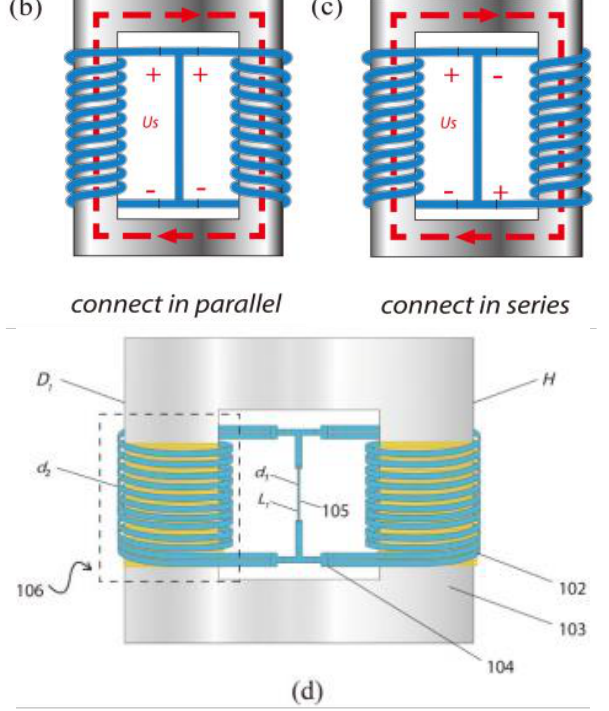
Figure 1. ( a ) Principle of IEF generator; ( b ) Parallel connection; ( c ) Series connection; ( d ) IEF generator with MSCP and VDC structure.